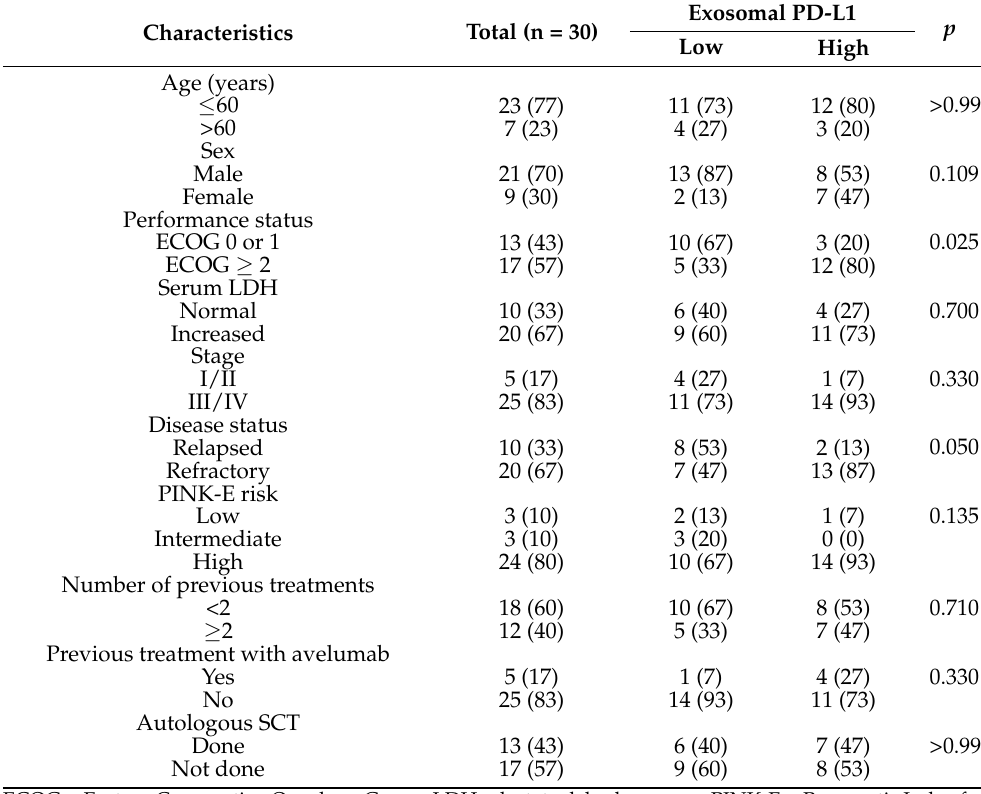
Table 1. Characteristics of patients at the time of pembrolizumab